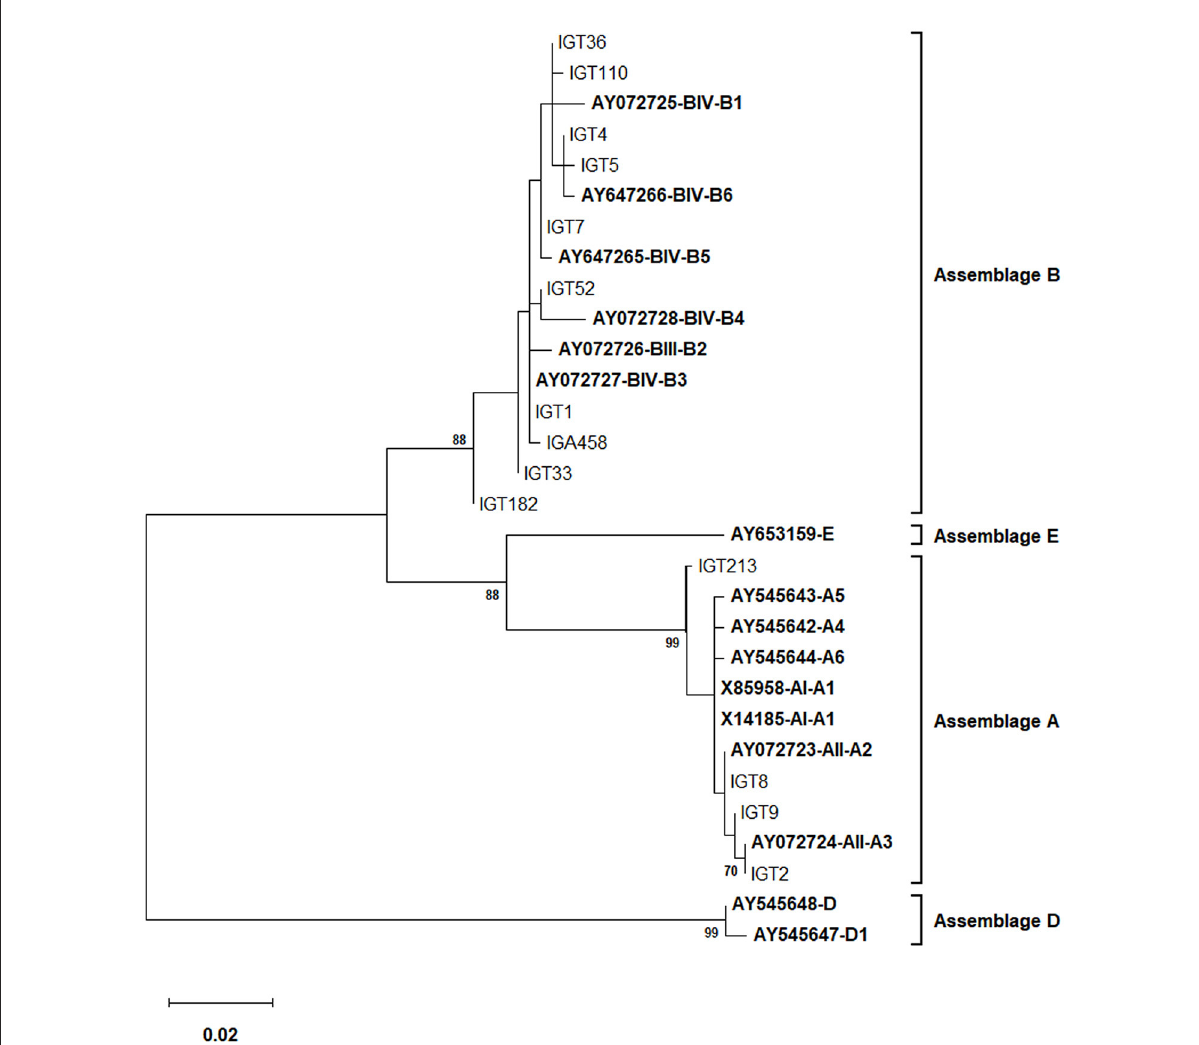
FIGURE2 The phylogenetic analysis of the bg gene nucleotide sequences of Giardia duodenalis using the Maximum Likelihood method (ML) and Tamura 3-parameter model (38) (T92 + G + I). The analysis involved 30 nucleotide sequences: 14 representative nucleotide sequences of bg retrieved from this study (LC183967–LC184028) compared with 16 reference sequences of known assemblages from Genbank which are indicated in bold. The percentage of trees in which the associated taxa clustered together (achieved from 1,000 replicates) is shown next to the branches, only bootstraps values > 50% are demonstrated. A discrete Gamma distribution was used to model evolutionary rate differences among sites [5 categories ( + G, parameter = 0.1294)]. The rate variation model allowed for some sites to be evolutionarily invariable [( + I), 42.59% sites]. The scale bar represents substitutions per nucleotide. The final dataset included 506 positions. Evolutionary analyses were conducted in MEGA X (39).